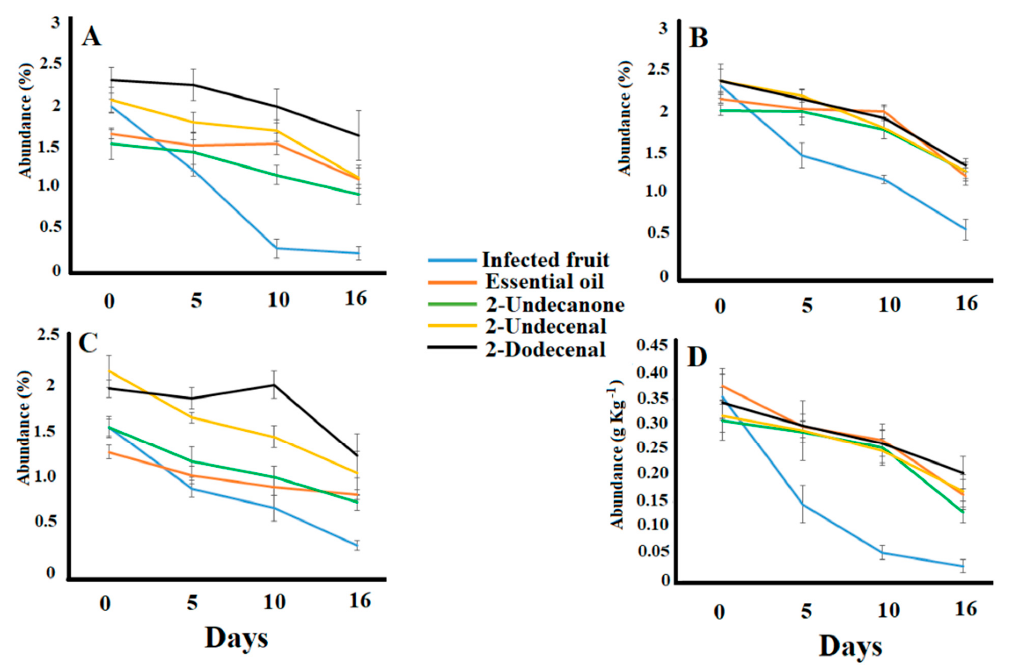
Figure 6. Protective effect of 120 mg L − 1 ZlEO, 150 mg L − 1 2-undecanone, 220 mg L − 1 2-undecenal, and 130 mg L − 1 2-dodecenal on the levels of fat ( A ), protein ( B ), fiber ( C ), and vitamin C ( D ) in manzano peppers during 16 d. Statistical analysis (ANOVA-Tukey-Test, n = 20) of these tests are included in Tables S3–S6.